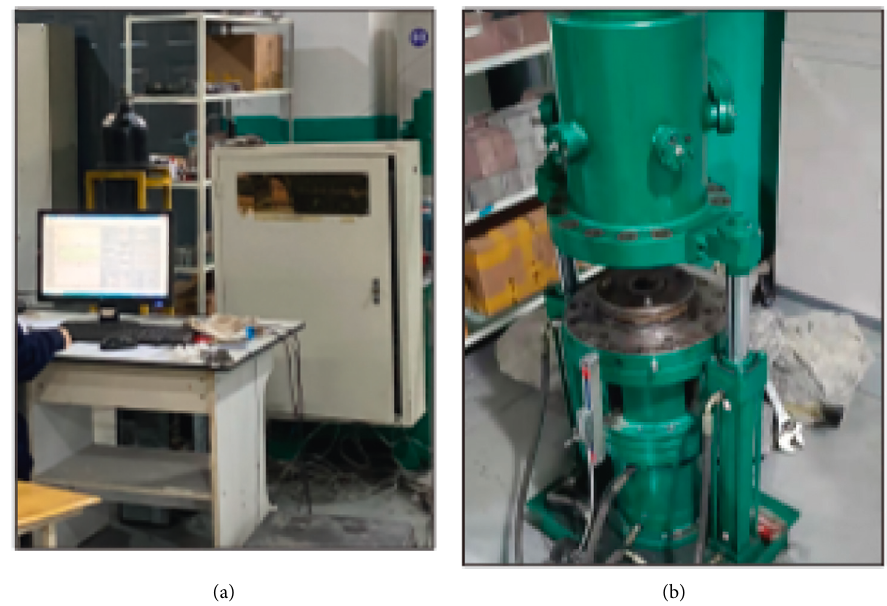
Figure 1: Visuable coal-rock fluid-solid coupling test system: (a) measurement and control system and (b) loading device.